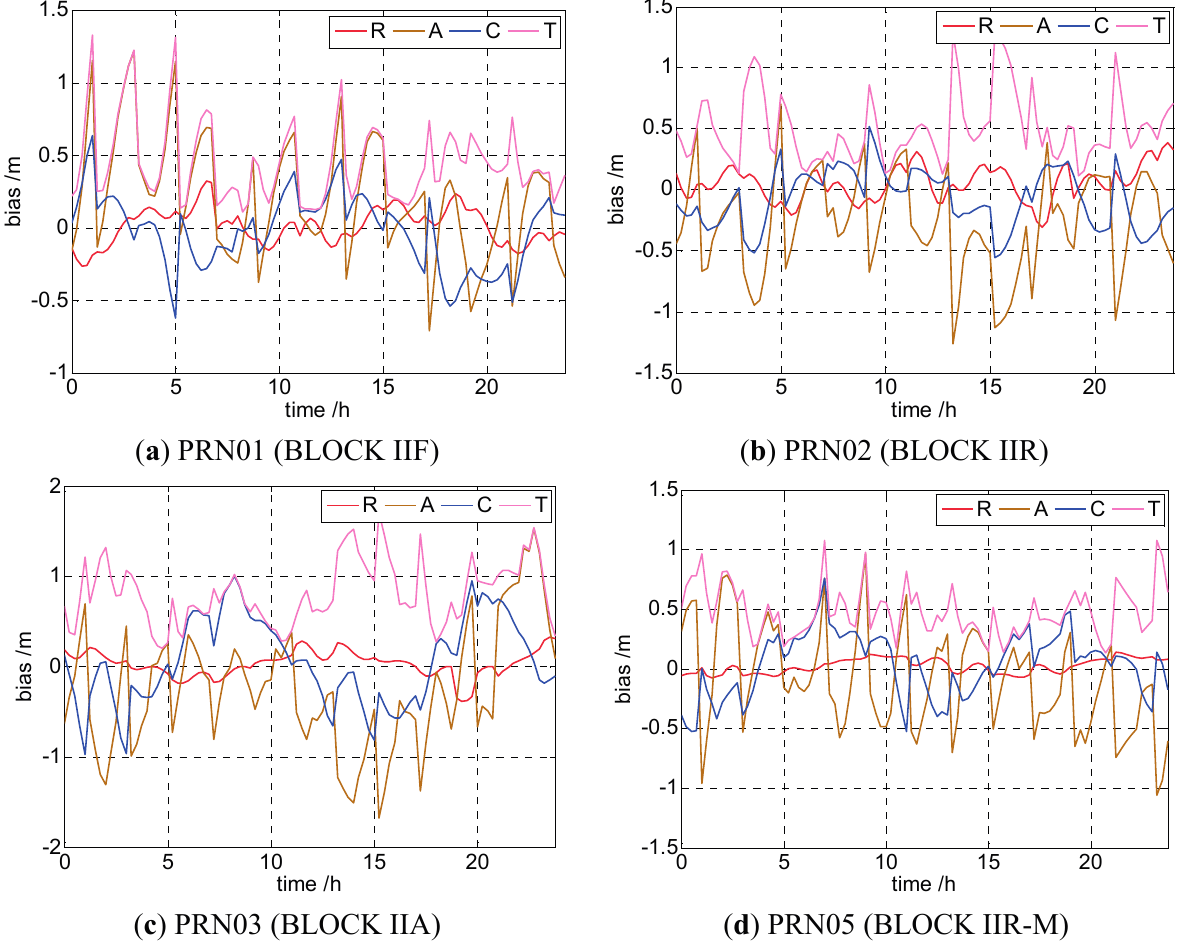
Figure 1. Orbit error statistics of the satellites with different types calculated from broadcast ephemeris. ( a ) BLOCK IIF; ( b ) BLOCK IIR; ( c ) BLOCK IIA; ( d ) BLOCK